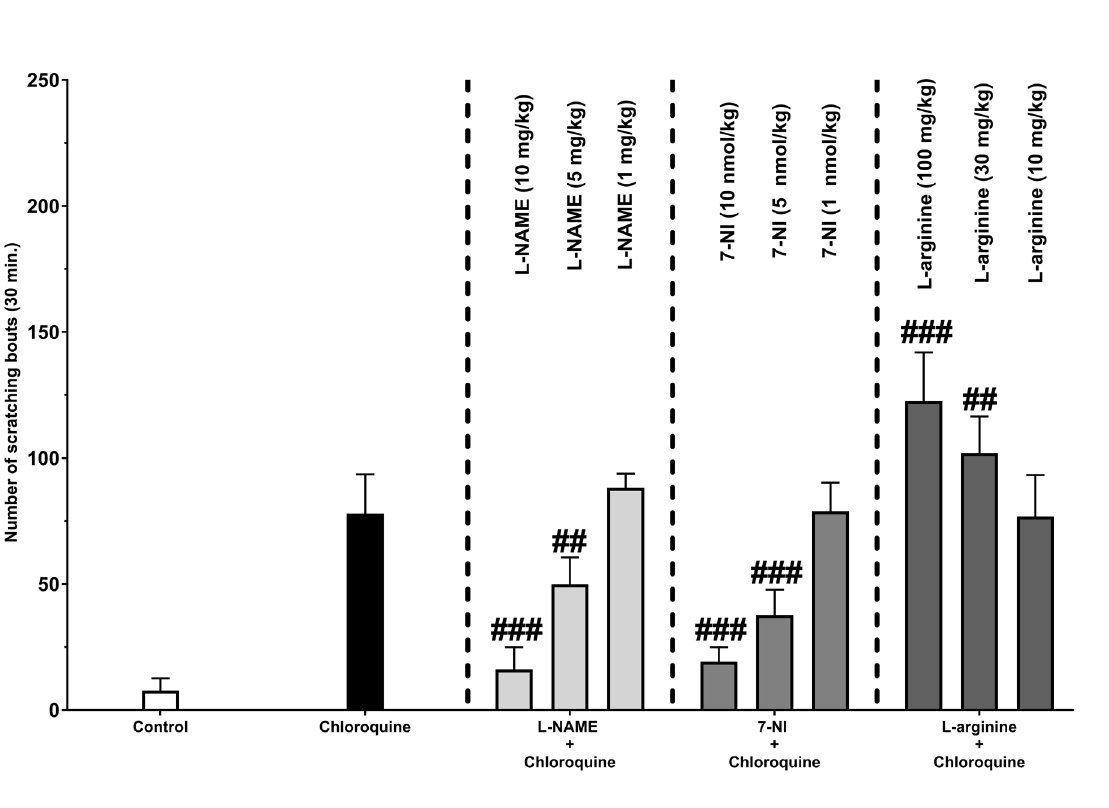
FIGURE 3 - Investigation of the possible role of NO in chloroquine-induced pruritus. Inhibition of NOS (L-NAME at 10 and 5 mg/kg) and nNOS (7-NI at 1.6 and 0.8 µg/kg) significantly decreased the numbers of chloroquine-induced scratching bouts. L-arginine (100 and 30 mg/kg) significantly enhanced the number of chloroquine-induced scratching bouts. All data represented as mean±SEM. ###p<0.001, ##p<0.01 versus chloroquine